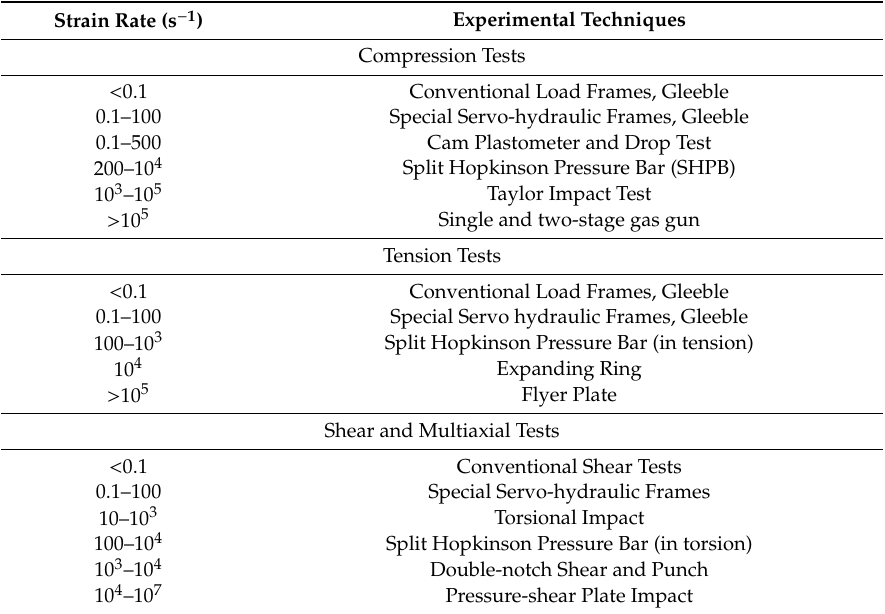
Table 1. Test methods for di ff erent regimes of strain rate